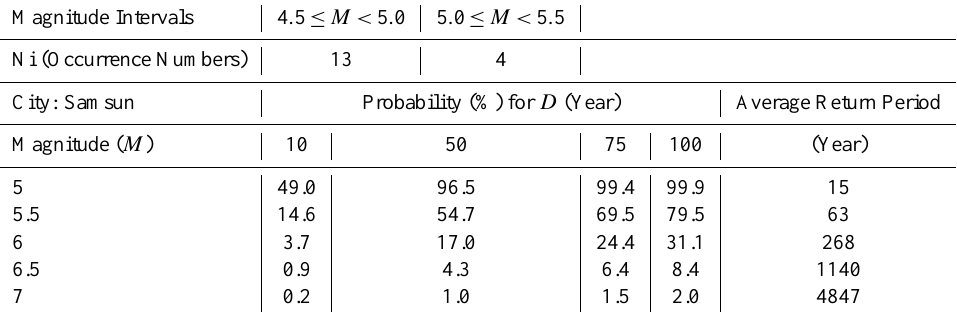
Table 3s. Earthquake occurrence probability (%) for D (Year) for Samsun city.